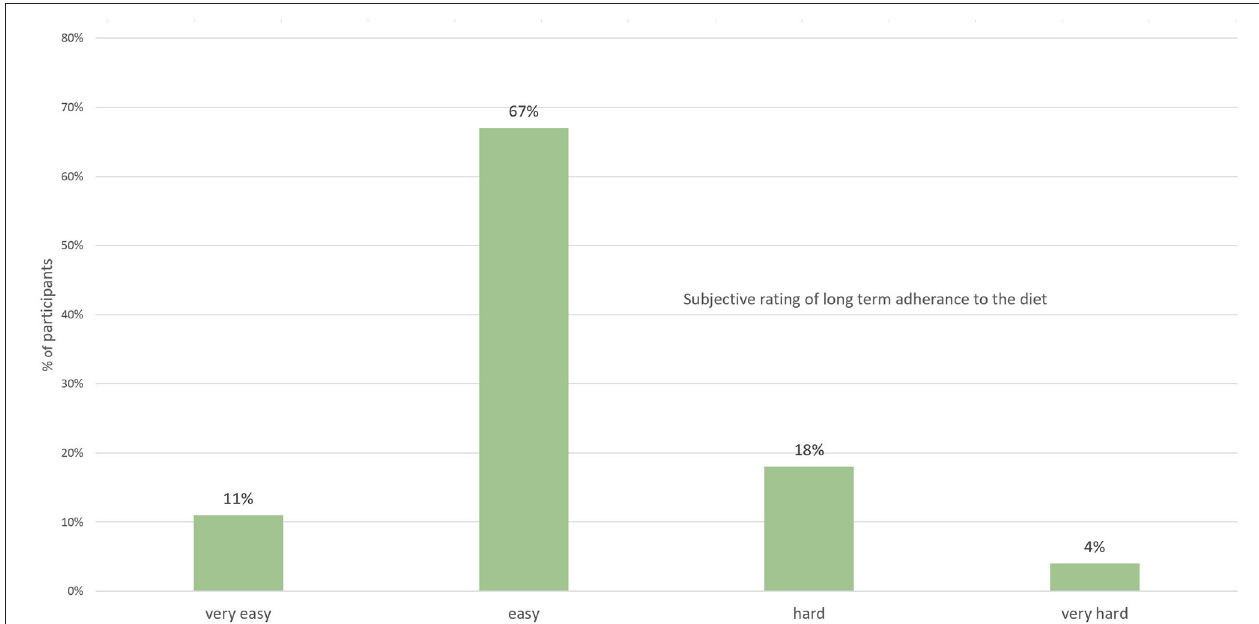
FIGURE 2 | Subjective rating by participants on the difficulty to adhere to the diet long term ( n = 94).